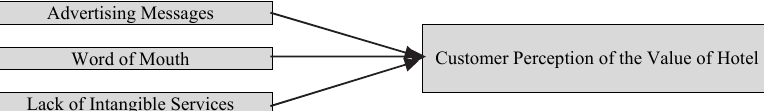
Fig. 1. The proposed